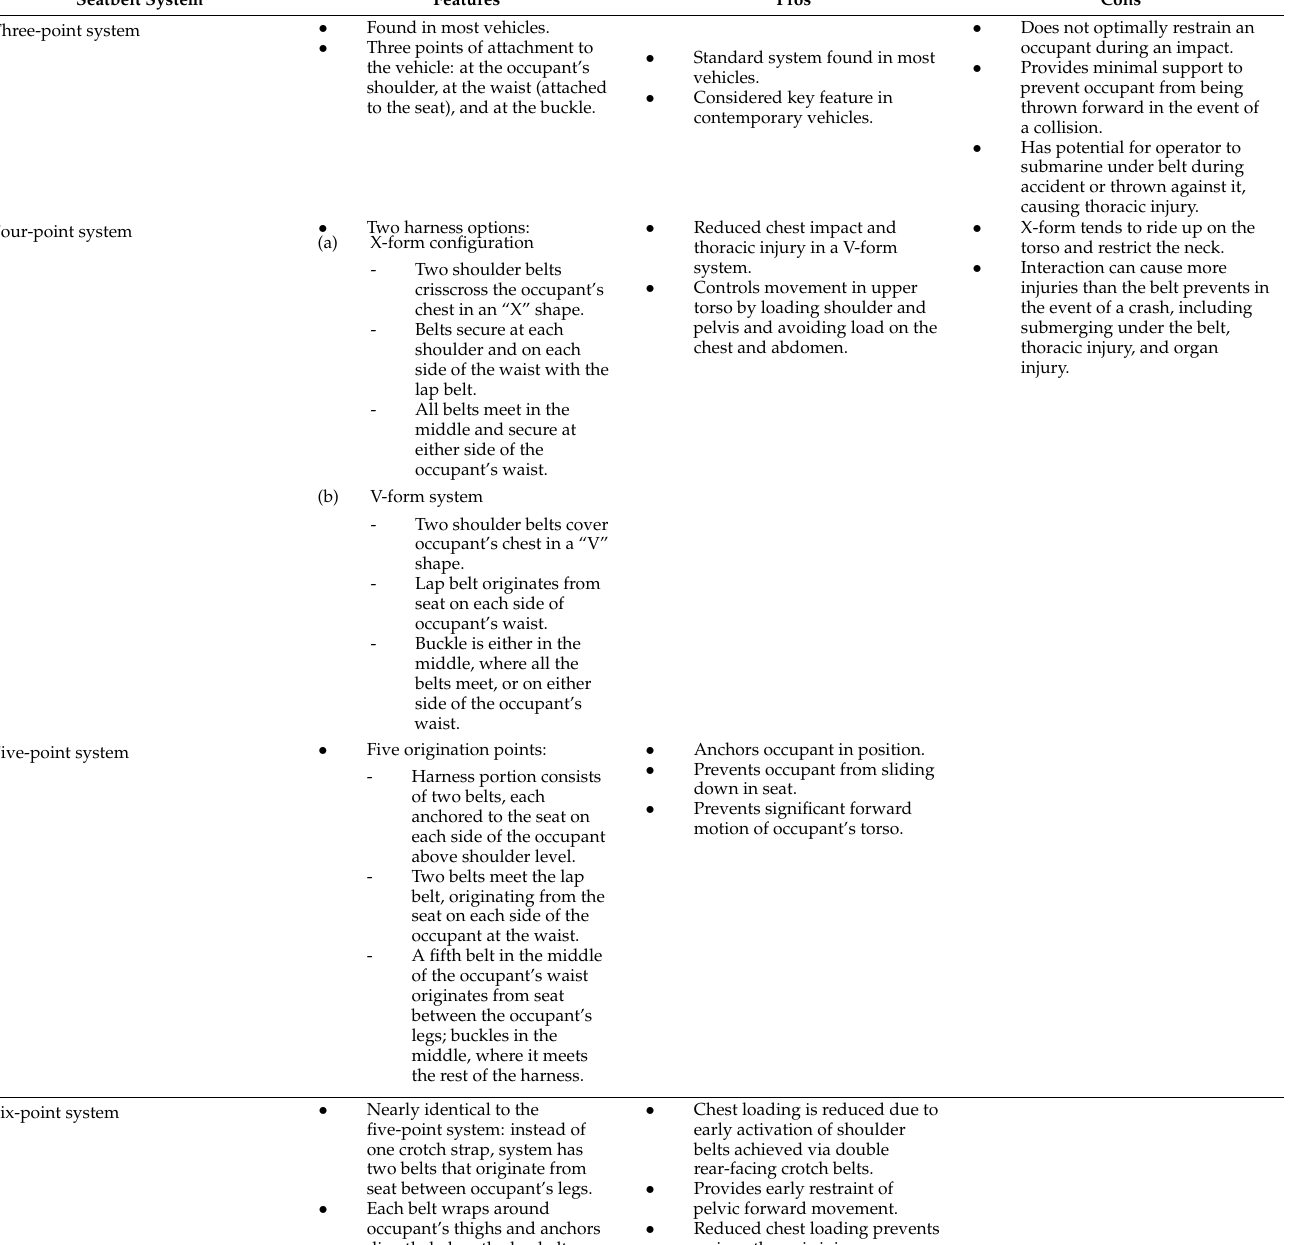
Table 14. Seatbelt systems in construction vehicles